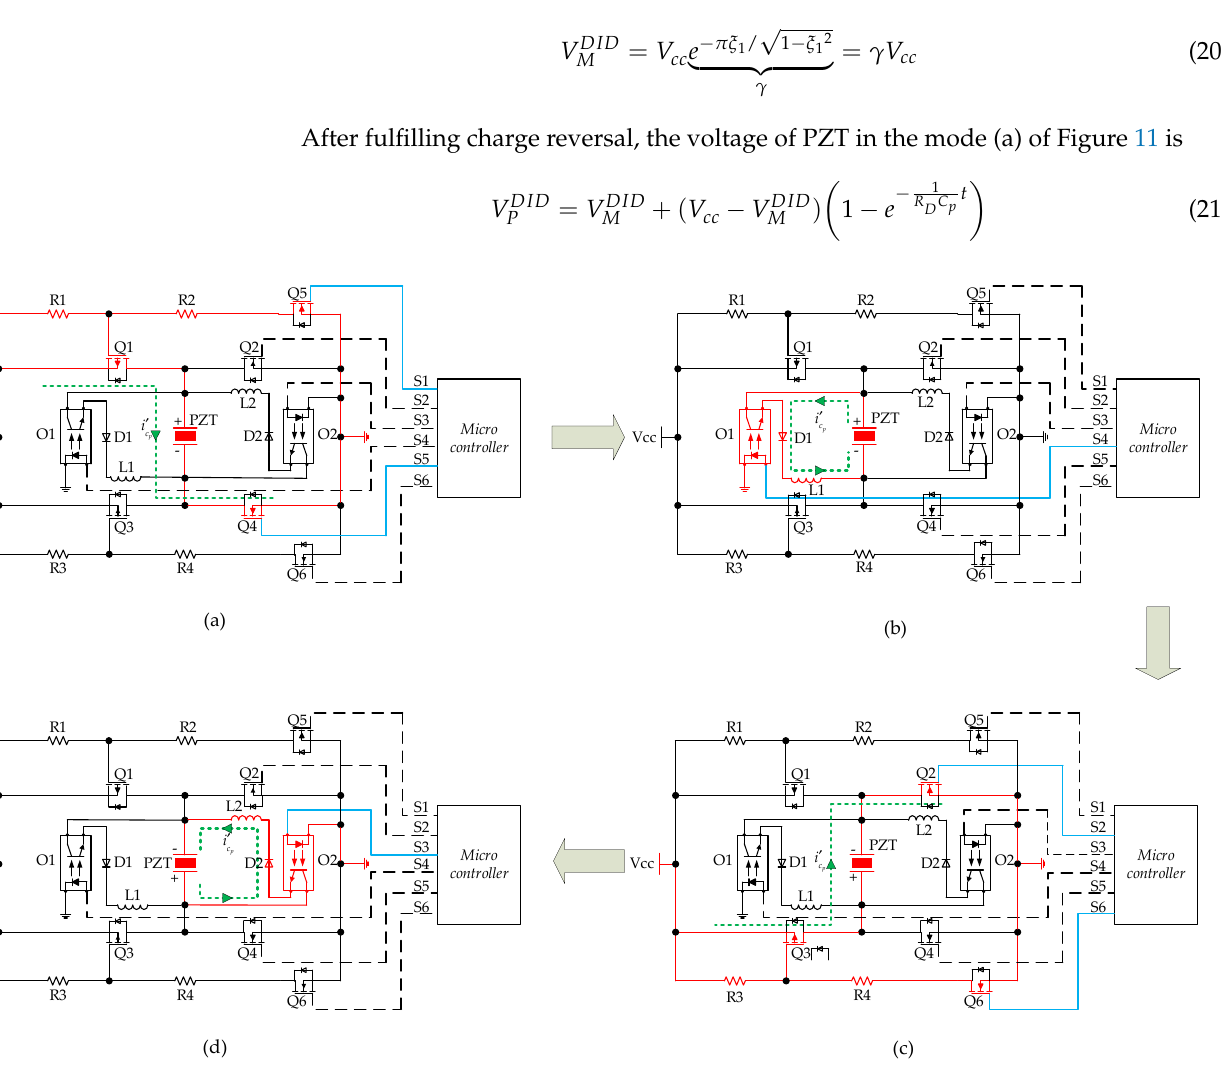
Figure 10. Switching waveforms of the DID circuit.